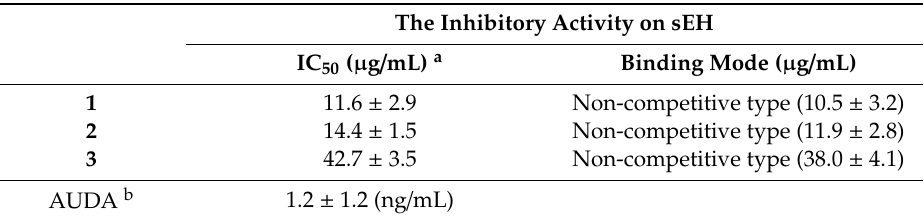
Table 1. The soluble epoxide hydrolase (sEH) inhibitory activities and enzyme kinetics of flavonoids.